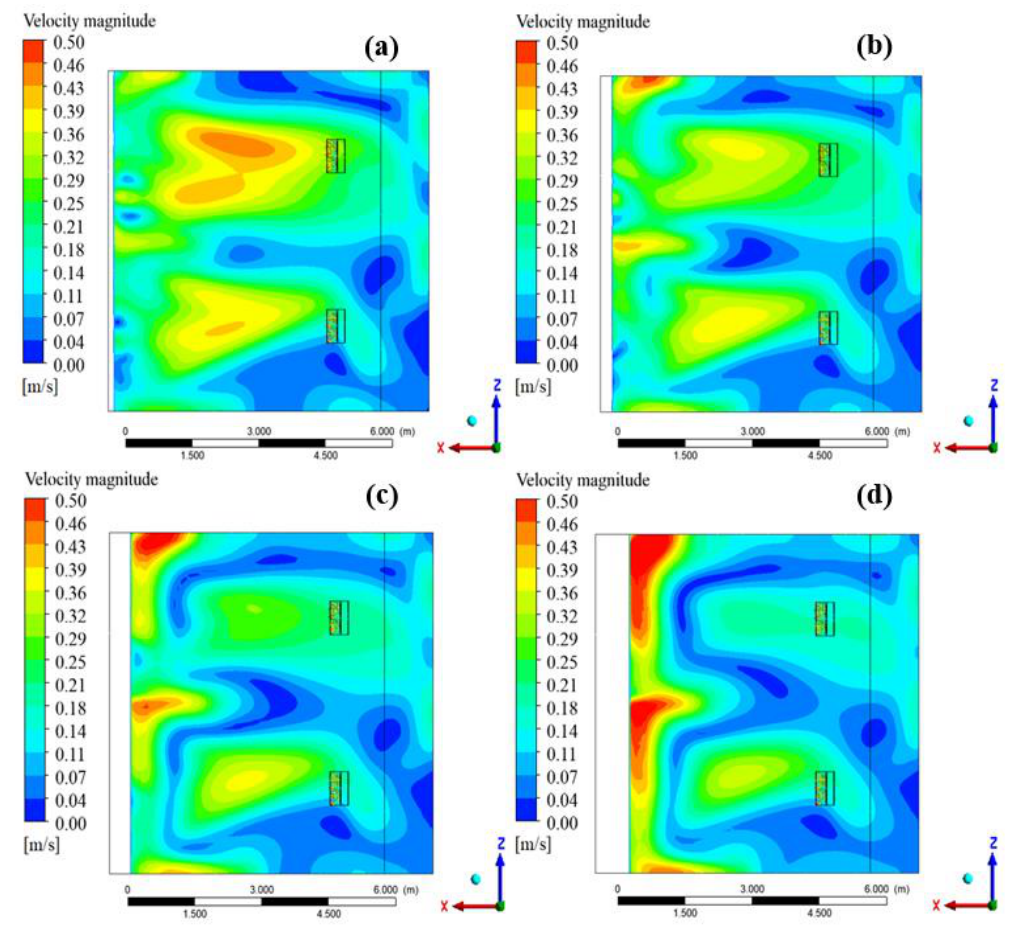
Figure 14. Velocity distribution contours for four horizontal profiles when the fan tilt angle was − 2.5°: plane 1 — 0.7 m ( a ), plane 2 — 1.0 m ( b ), plane 3 — 1.3 m ( c ), and plane 4 — 1.6 m ( d ).